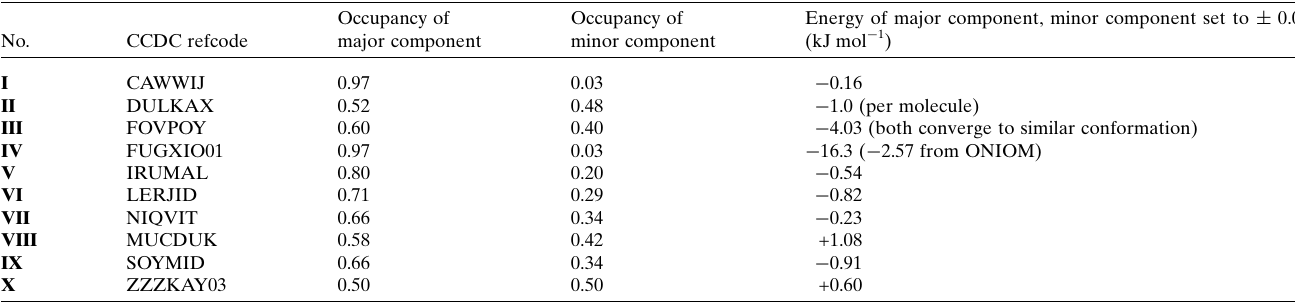
Table 2 A summary of energies and their relation to occupancies.